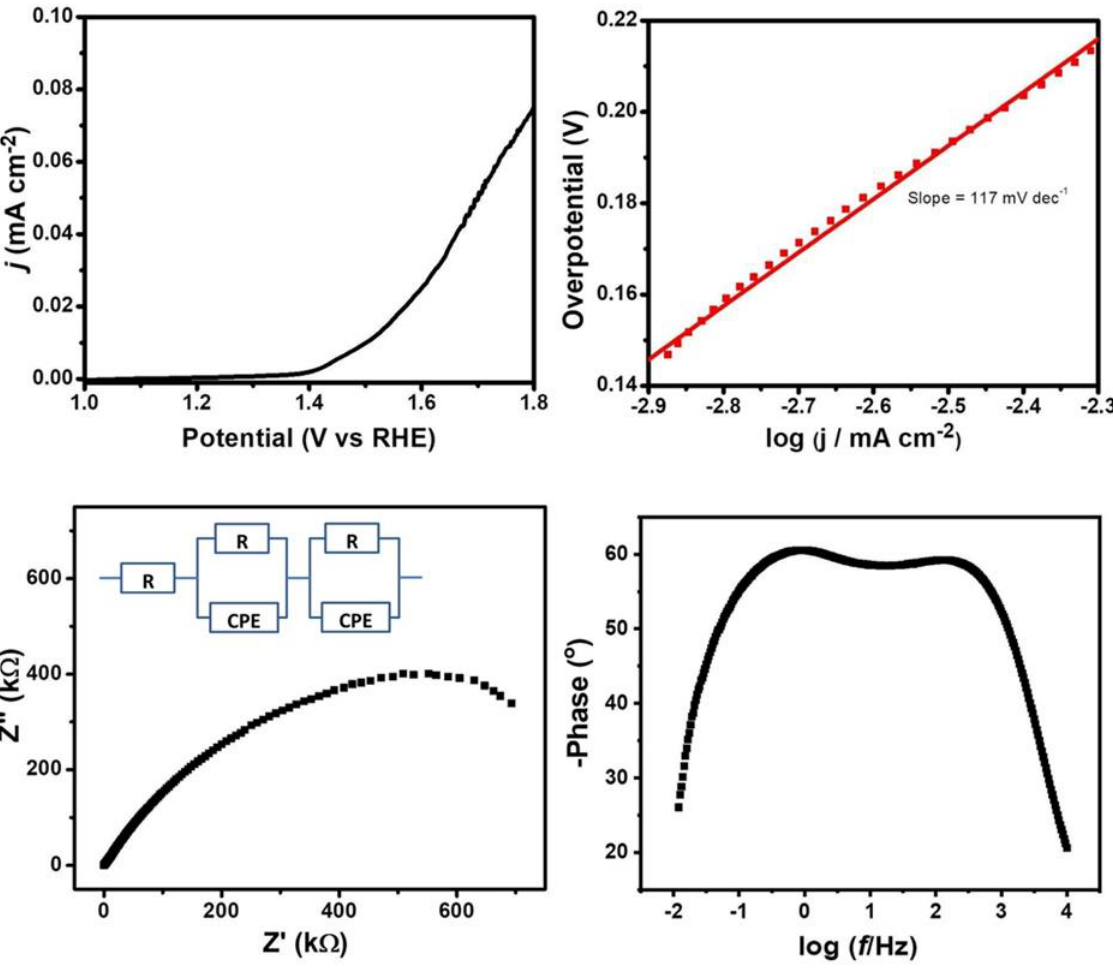
Figure 4. ( Top ) LSV plot at 10 mv sec − 1 scan rate and corresponding Tafel plot and ( bottom ) Nyquist (with equivalent circuit diagram) and Bode plots from the EIS study of Cu 2 WS 4 in 0.1 M KOH solution.